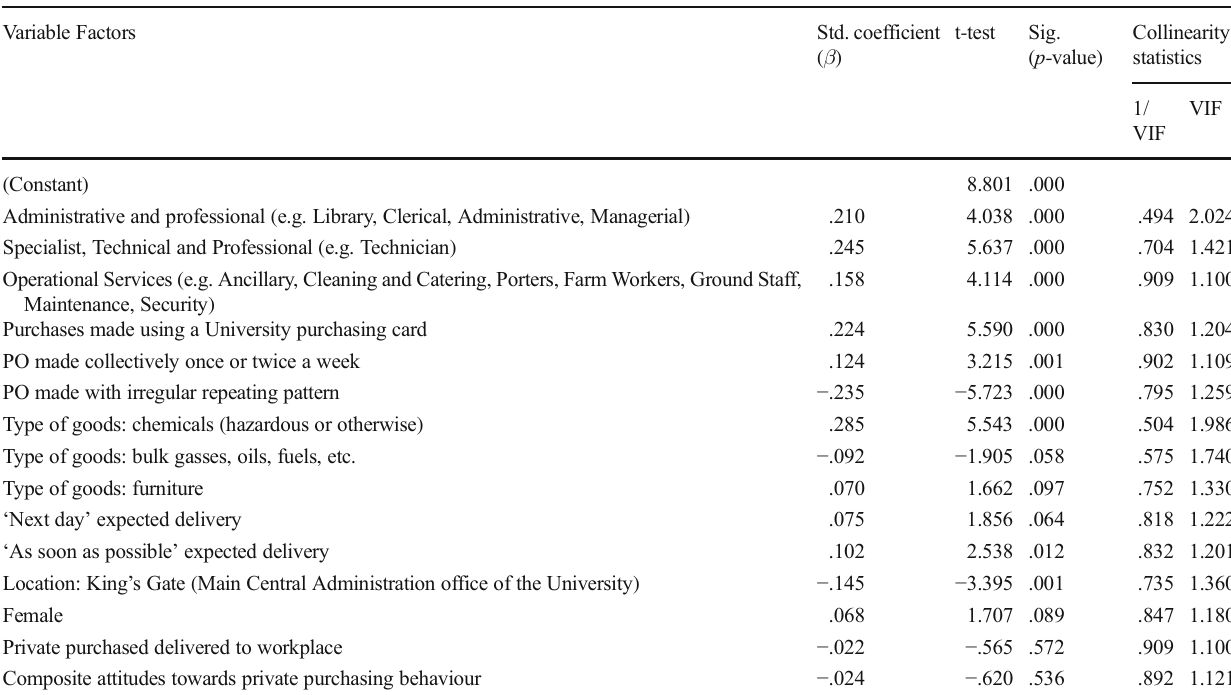
OLS Regression for PO frequency on Newcastle University staff Variable